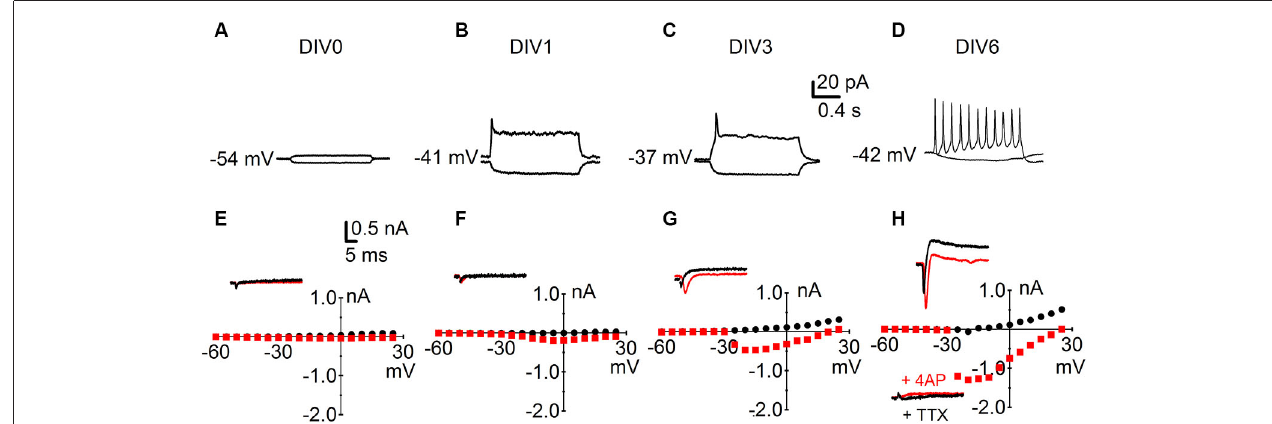
currents (black). Data points for the I-V curves plot peak inward current (red squares) against the holding potential after depolarization and the sustained outward current (black dots) against the holding potential after depolarization. Corresponding time points: (E) DIV 0; (F) DIV 1; (G) DIV 3 and (H) DIV 6 top insert currents under baseline condition and bottom insert currents after bath application of TTX (1 µ M) and 4 AP (1